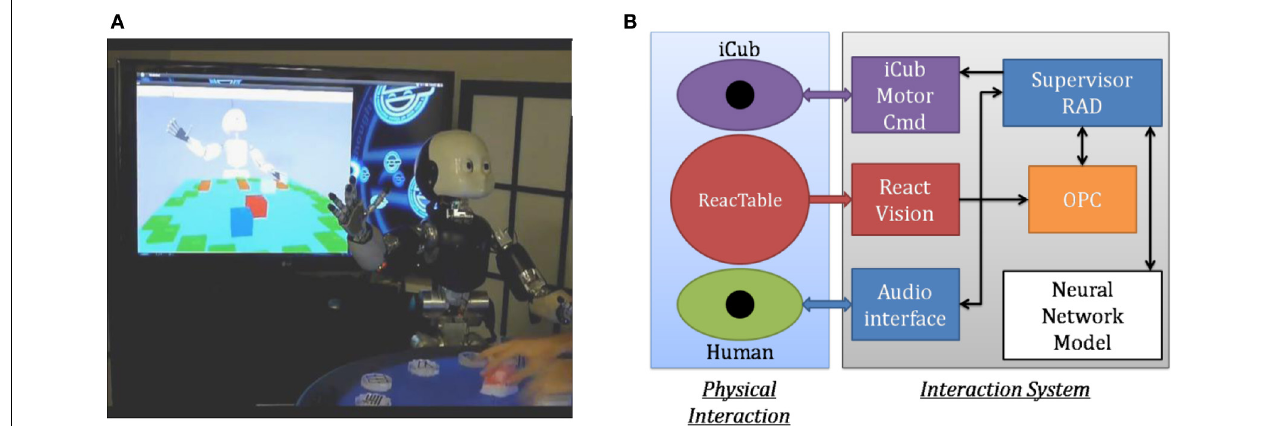
FIGURE 2 | Robotic Platform. (A) iCub humanoid robot with the ReacTable. (B) System architecture overview. The Supervisor coordinates all interactions between the human and the different components of the system. When the human moves an object on the ReacTable, the coordinates are transformed into the robot space, and stored in the Object Properties Collector (OPC). For Action Performance when the human speaks, the words are recognized by the audio interface, then they are packaged and sent to the Neural Network by the Supervisor. Resulting commands from the Neural Network are